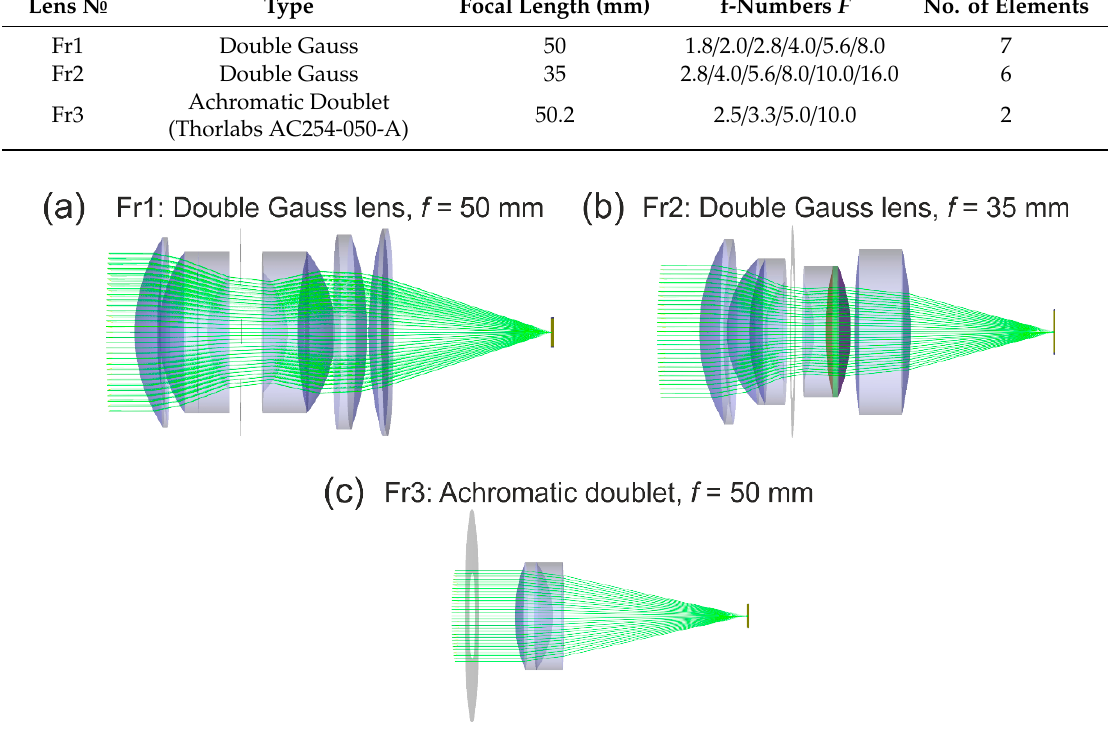
Figure 20. Optical layout of modeled (camera) lenses: ( a ) Lens Fr1 of double Gauss type, ( b ) lens Fr2 of double Gauss type and ( c ) achromatic doublet lens Fr3.